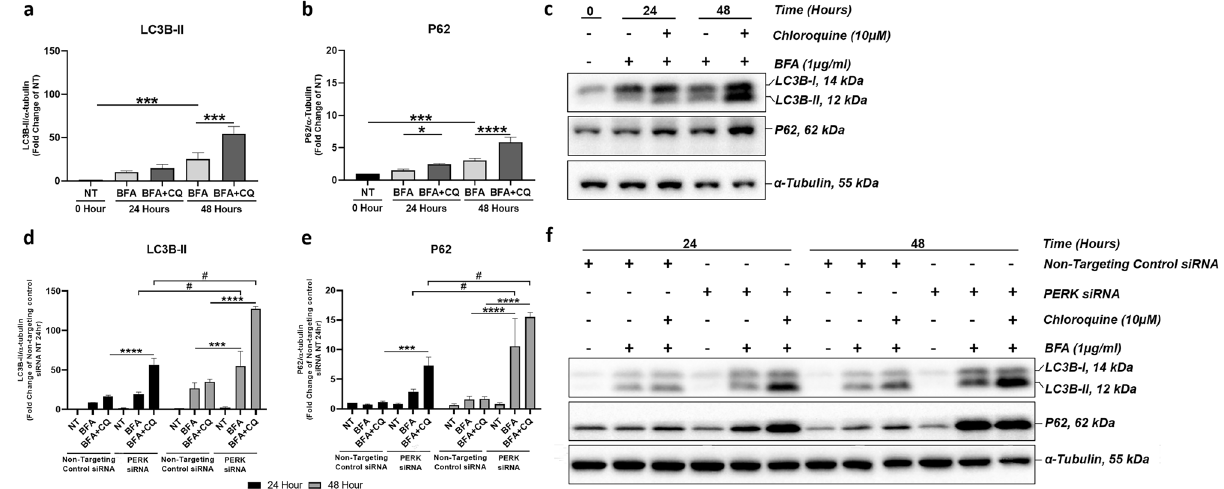
Figure 4. PERK regulates the induction of autophagy in ARPE-19 cells following ER stress. ER stress induced with 1 μg/ml BFA in ARPE-19 cells led to significantly increased protein levels of LC3B-II ( a ) at 48-h time point and P62 ( b ) at 24- and 48-h time points. Combined lysosomal inhibition using 10 μM CQ and 1 μg/ml BFA-induced ER-stress further increased LC3B-II and P62 protein expression at 24 and 48-h time points. ( c ) Representative immunoblots of BFA/CQ-treated ARPE-19 cells. When ER stress was induced in the presence of PERK siRNA, there was a significant increase in both LC3B-II ( d ) and P62 ( e ) at 48-h time point, with further significant increases in levels of both proteins in the presence of CQ when compared to non-targeting control siRNA groups. ( f ) Representative immunoblots of BFA/CQ-treated ARPE-19 cells, with and without PERK downregulation through siRNA knockdown. Results are presented as fold changes from the NT 0-h time point ( a , b ) and from the NT non-targeting control siRNA, 24-h time point ( d , e ). Protein levels were normalised to α-tubulin. Means ± standard deviation shown (n = 3). Statistical analysis was performed using a one-way ANOVA with Sidak’s multiple comparison test ( a , b ). Statistical analysis comparing treatment groups within each respective 24- and 48-h time point used a two-way ANOVA with the TukeyHSD post-hoc test ( d , e ) (* p ≤ 0.05, *** p ≤ 0.001, **** p ≤ 0.0001). Statistical analysis comparing groups across time-points used a two-way ANOVA with Sidak’s multiple comparison test (# = **** p ≤ 0.0001). NT Non-treated, BFA Brefeldin-A, CQ